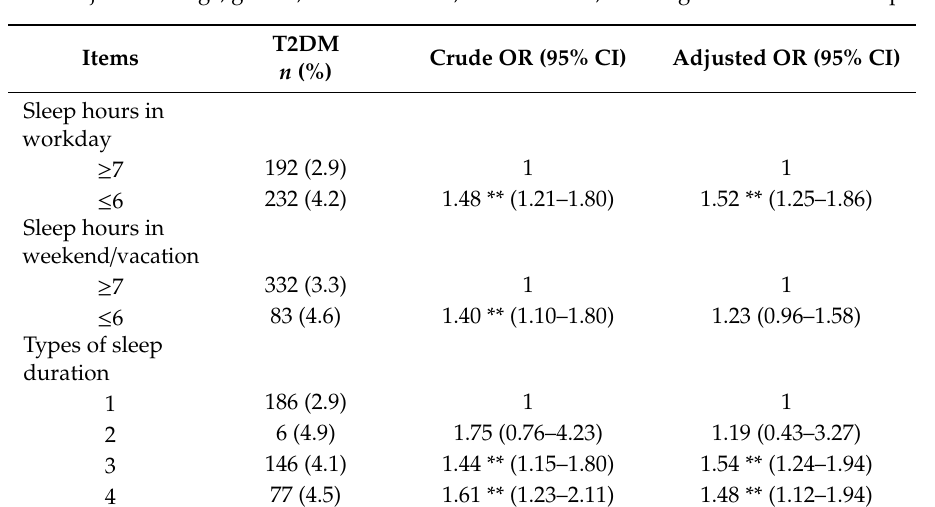
Table 3 indicates the associations between sleep duration during the workday and on weekends / vacations with T2DM using multiple logistic regression, adjusted for age, gender, education level, marital status, and smoking and alcohol consumption. People with SSD for workdays and weekends / vacations had respectively 1.52 and 1.23 times the ORs of T2DM, but there was only a statistical significance for workdays. Four kinds of sleep duration were significantly associated with T2DM. People with SSD for both workday and weekend / vacation (level 4) had 1.48 times OR of T2DM. In addition, the OR of T2DM was 1.54 times greater for the group with SSD in the workday and LSD on weekends / vacations (level 3). Table3. Sleephoursonworkdaysandonweekends / vacationsassociatedwithT2DMusingmultiplelogistic regression adjusted for age, gender, education level, marital status, smoking and alcohol